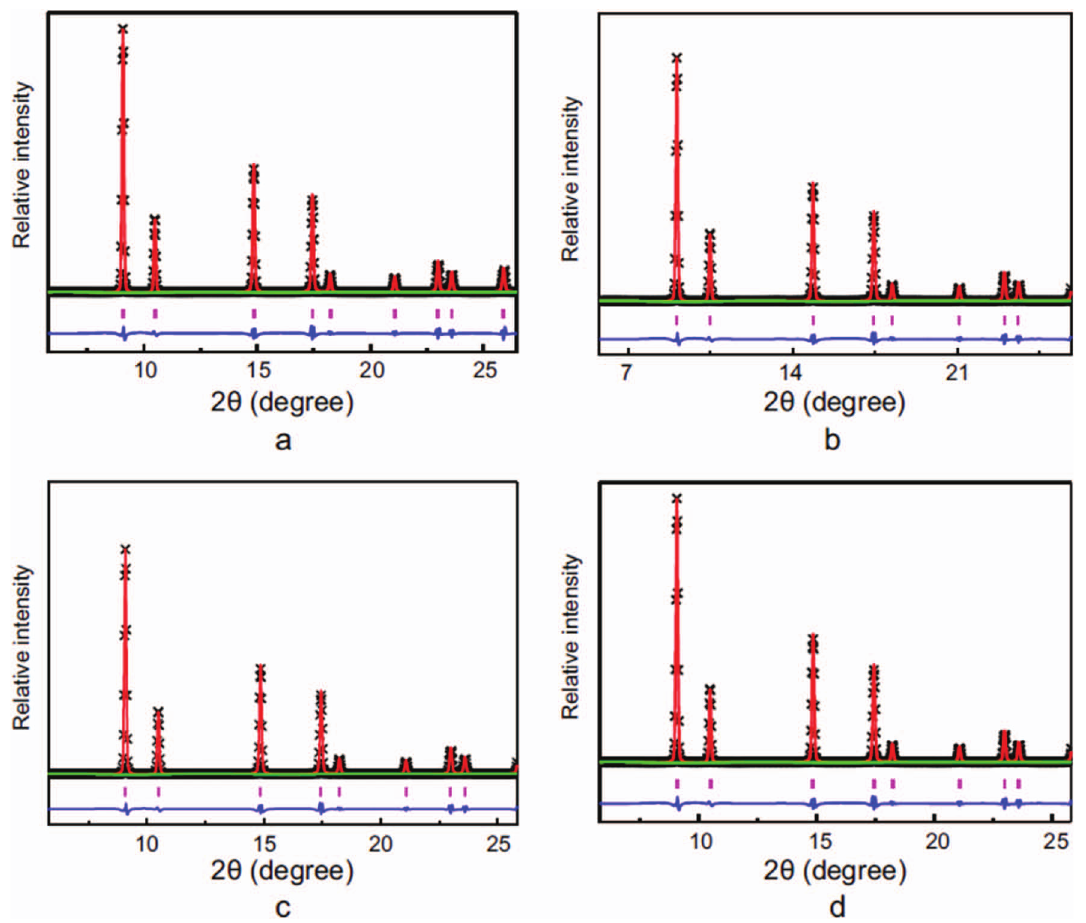
Fig. 5. The RDC series Rietveld re fi nement results for sample powders sintered at 1500 – 1600 (cid:1) C, (a) LaDC, (b) SDC, (c) GDC, and (d)